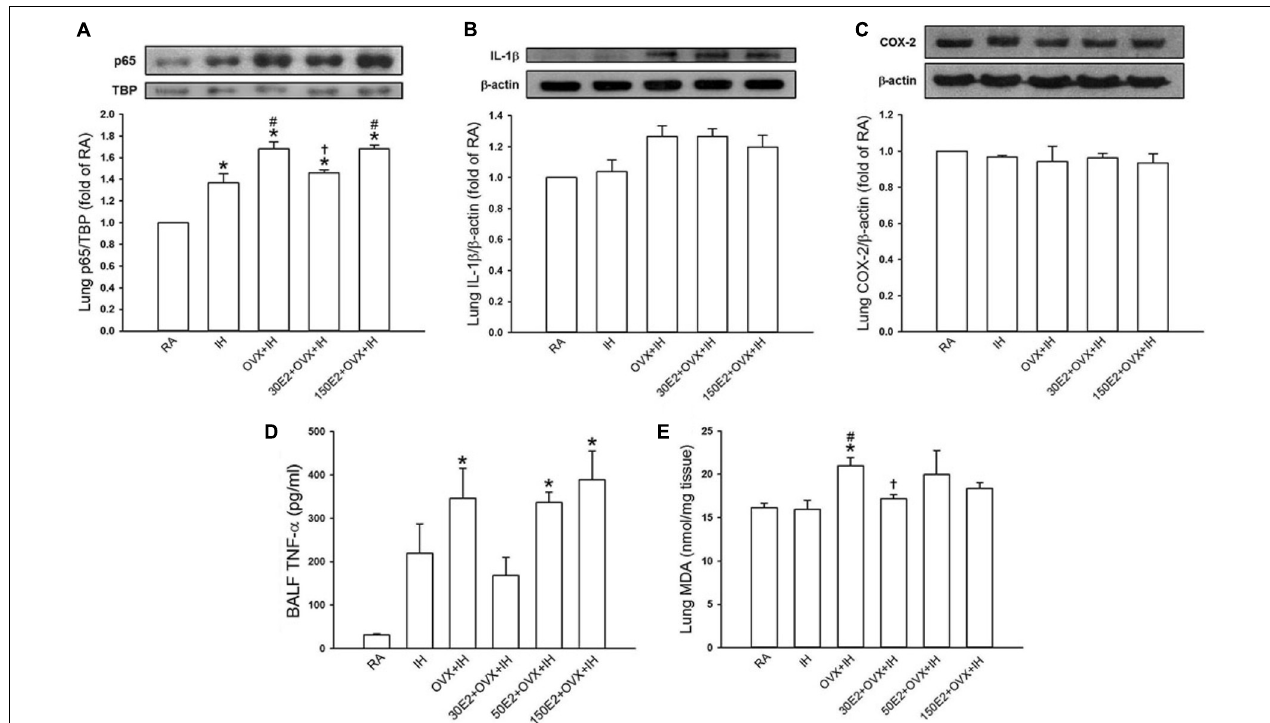
FIGURE 7 | Expression of inflammatory cytokines and cyclooxygenase-2 (COX-2) and level of malondialdehyde (MDA) in lung samples and BALF from female rats. Two groups of intact rats were exposed to RA or IH for 14 days. The four other groups consisted of OVX rats (OVX + IH) or OVX rats receiving E2 replacement at the concentrations of 30, 50, and 150 µ g/ml (30E2 + OVX + IH, 50E2 + OVX + IH, 150E2 + OVX + IH) and exposed to IH for 14 days. In (A) , the levels of the protein expression of the p65 subunit of NF- κ B in the nucleus of lung tissue samples were analyzed through Western blot analysis to assess NF- κ B activation. The protein levels of interleukin-1 β [IL-1 β (B) ] and COX-2 (C) in the lung tissues were measured. The BALF level of TNF- α (D) and the lung level of MDA (E) , an indicator of oxidative stress, in these groups were analyzed through ELISA and an assay kit, respectively. These indices were measured and served as indications of lung inflammation. ∗ p < 0.05 compared with responses of RA rats; # p < 0.05 compared with responses of IH rats; † p < 0.05 compared with OVX + IH rats. Data in each group are presented as means ± SE of five